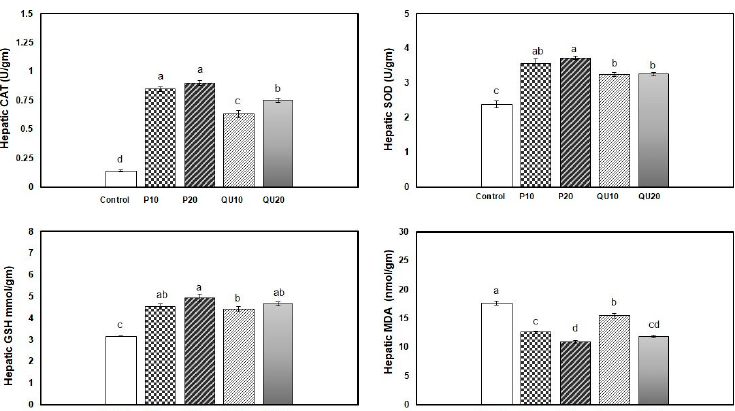
Figure 2. Effect of PP or QU supplementation at 10% and 20% for 45 days on the antioxidant status and oxidative stress variables in Nile tilapia. Values are expressed as mean ± SE ( n = 6/group). The values that do not share a common superscript letter differ significantly at p < 0.05 by one-way ANOVA, followed by Tukey’s B post hoc test. PP 10 : prickly pear fruit peel-supplemented group